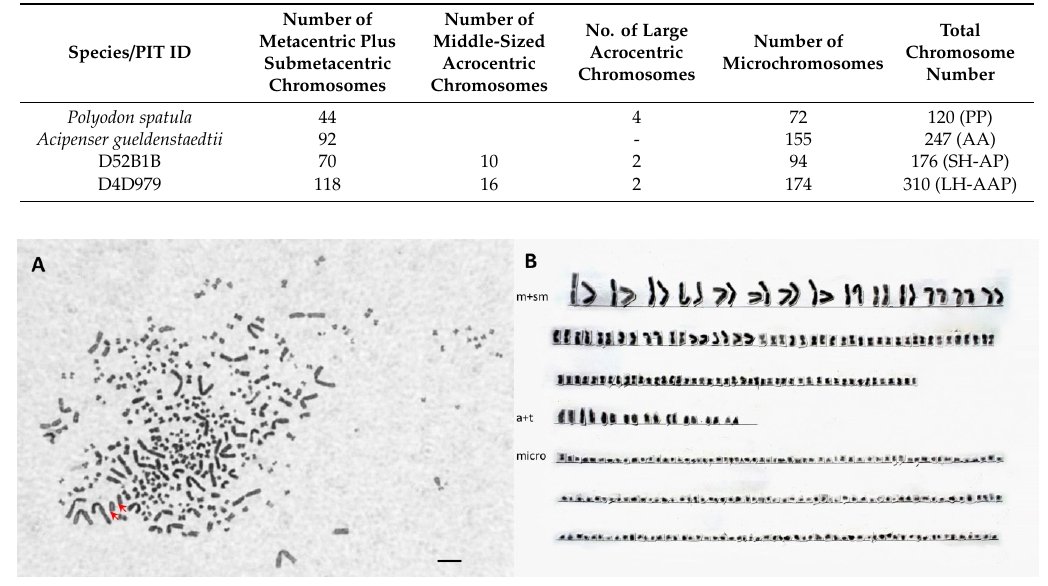
Figure 2. Mitotic metaphase chromosome spread ( A ) from fibroblast cell culture of the pectoral fin of an LH (large genome size hybrids) individual (No. D4D979). ( B ) Corresponding karyotype of A. gueldenstaedtii. x P. spathula. pentaploid hybrid. Red arrows show the paternal ‐ originated two large acrocentric chromosomes from P. spathula. Bar 5 μ